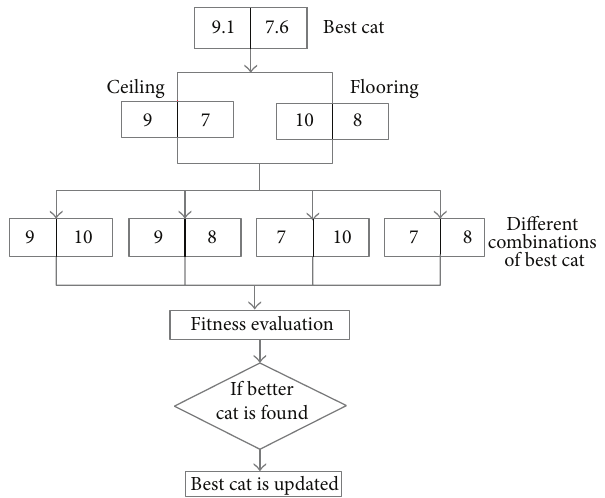
Figure 2: Modified seeking mode.